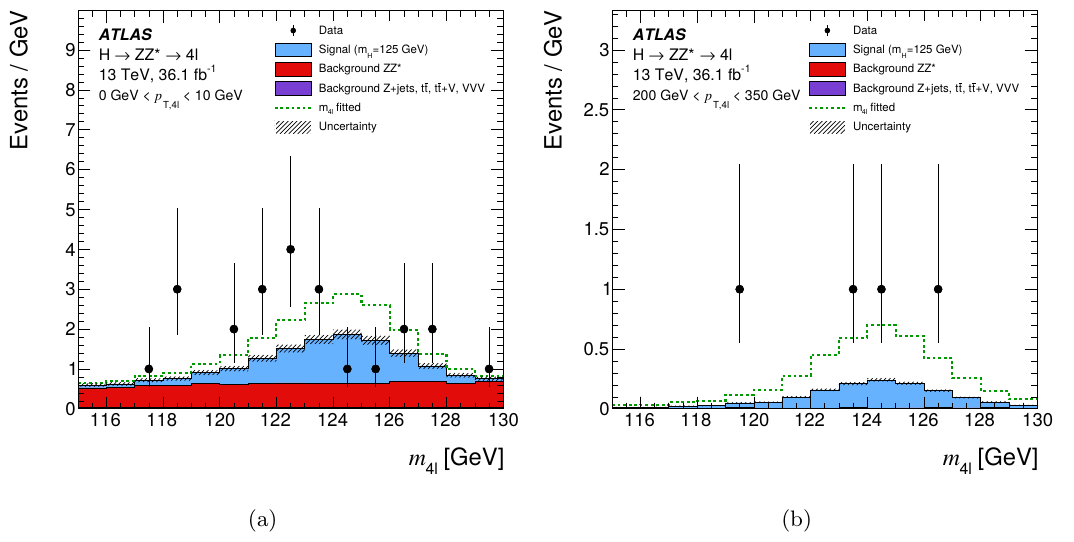
Figure 5. Template (cid:12)t of SM Higgs boson signal and background to the data for the (a) (cid:12)rst and (b) last bins of the distribution of the transverse momentum of the four leptons p T ; 4 ‘ . The error bars on the data points indicate the statistical uncertainty. The SM Higgs boson predictions are normalized to the cross sections discussed in section 3, while the backgrounds are normalized to the estimates described in section 6. The uncertainty in the prediction is shown by the dashed band. The dotted green line illustrates the best (cid:12)t.